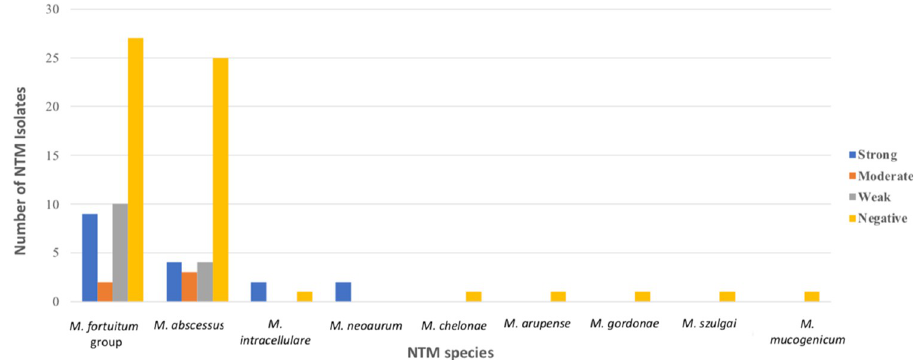
Fig 2. Ability to form biofilms by various NTM species. Most of the tested isolates of the M . fortuitum group and M . abscessus were unable to form biofilms. The number of isolates in the M . fortuitum group that formed a strong biofilm was higher than that of M . abscessus . Most other species could not form biofilms.